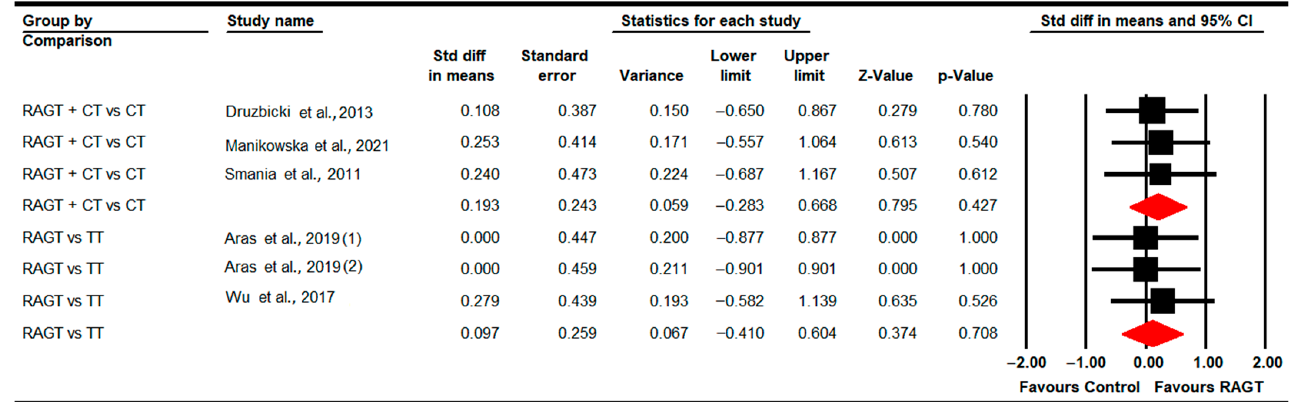
Figure 3. Forest Plot of Step Length (Post-Intervention Assessment) [79,80,83,85,88].